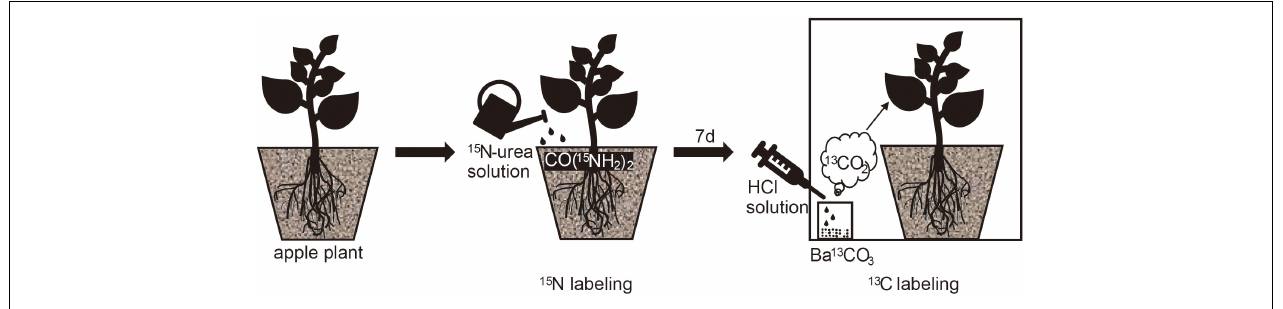
FIGURE 1 | The 13 C and 15 N double isotope labeling experiment.